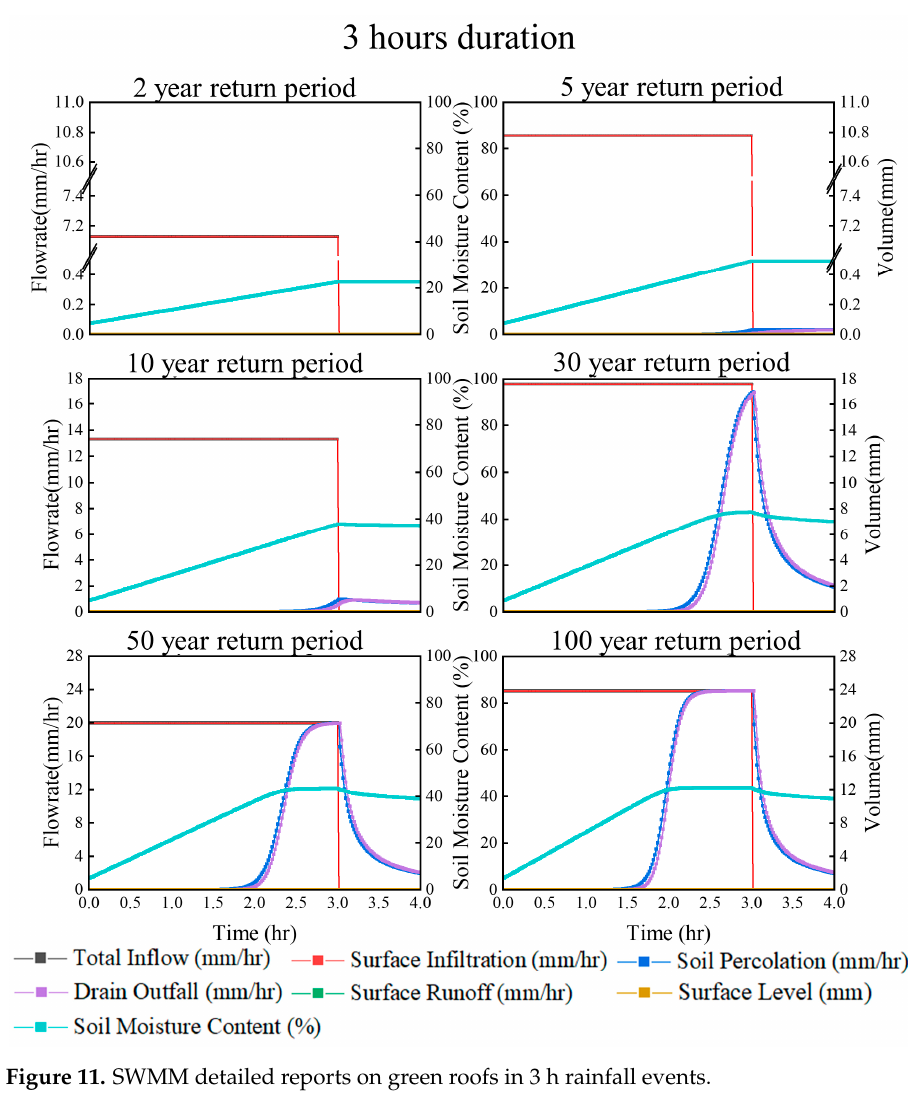
Figure 11. SWMM detailed reports on green roofs in 3 h rainfall events.